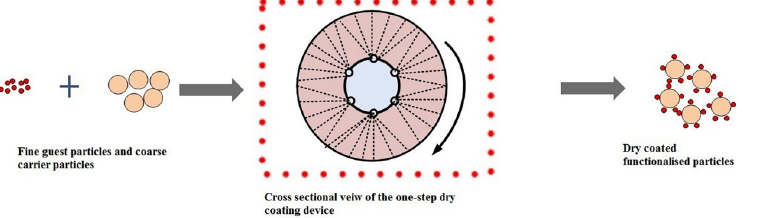
Fig 2. Schematic showing dry coating process and device. Fine agglomerated guest particles and coarse carrier particles are added to the high G-force processing vessel coupled with nitrogen gas flow to produce dry coated FP in a one step